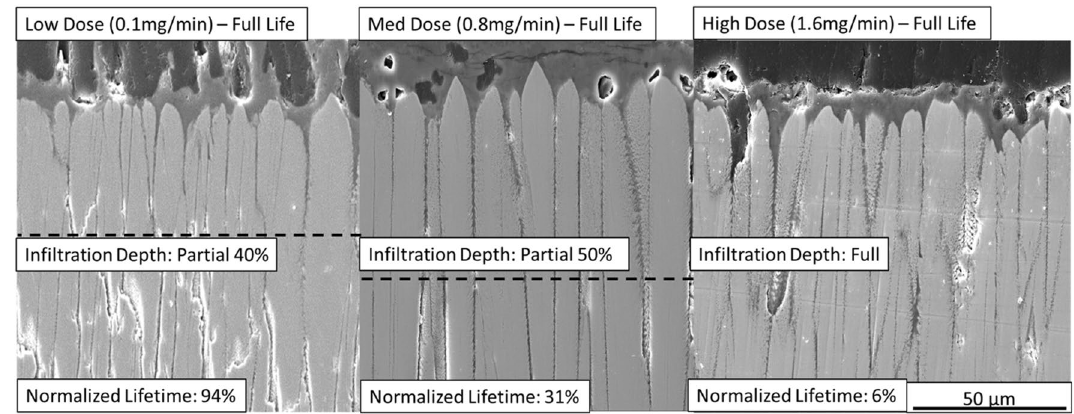
Fig. 6 Infiltration depths and normalized lifetimes by deposition rate of the low, medium and high